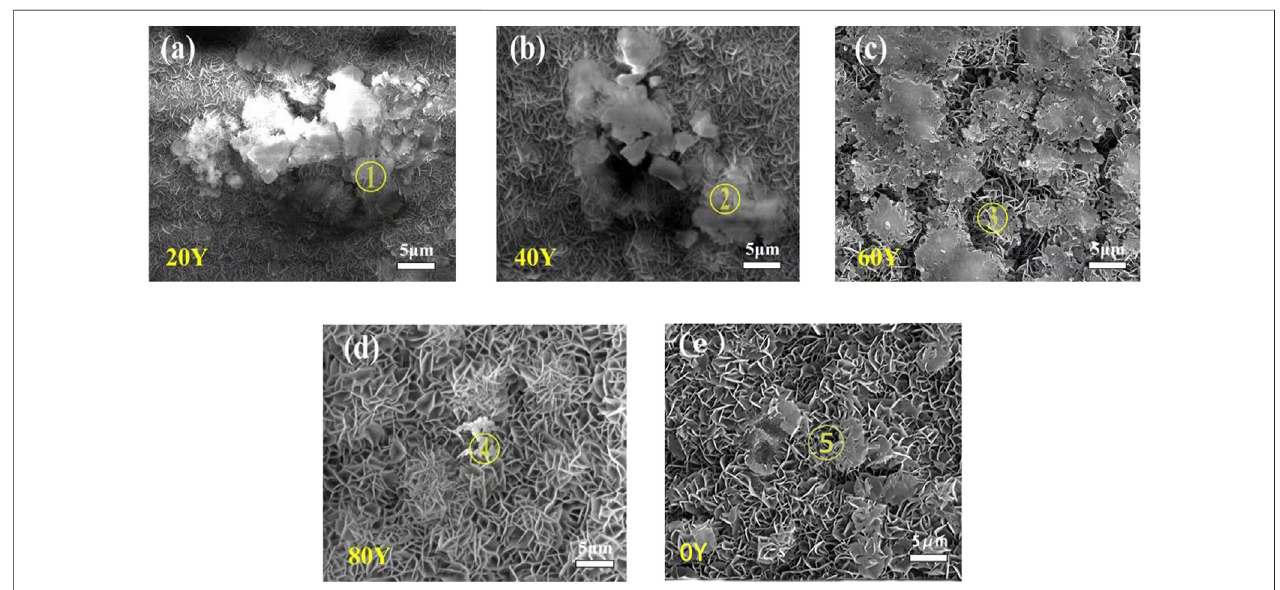
FIGURE 2 | SEM image of LDH specimens with different Y% fabricated on anodized oxide fi lms on Mg – 2Zn – 4Y alloys: 20Y (A) ; 40Y (B) ; 60Y (C) ; 80Y (D) ; and 0Y (E) .